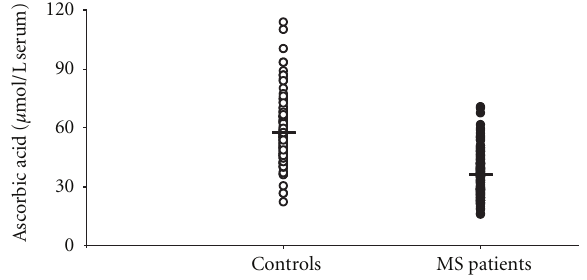
Figure 5: Scatter plot showing the concentration of ascorbic acid recorded in serum 163 healthy controls and 170 MS patients. Horizontal bars indicate the mean values calculated in the two